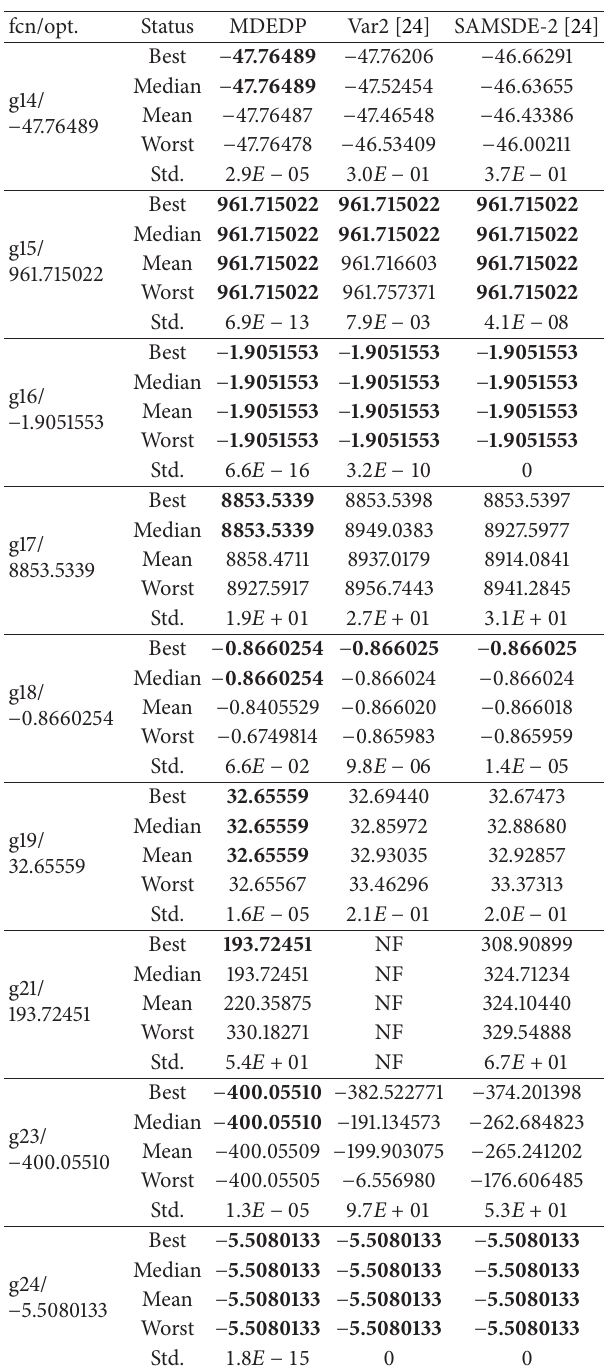
Table2:StatisticalresultsobtainedbyMDEDPover30independent runs and the comparison with Var2 [24] and SAMSDE-2 [24] for the remaining 9 test instances. “NF” means no feasible solution is